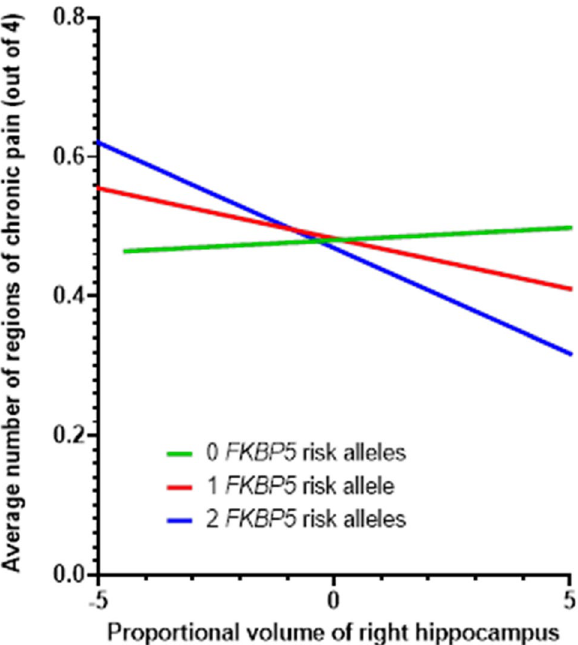
Figure 1. The number of FKBP5 rs3800373 risk alleles moderates the relationship between the right hippocampus and CMP severity. Shown is the relationship between right hippocampal brain volume and chronic multisite musculoskeletal pain (CMP) severity in individuals from the UKBB study cohort (n = 36,822). Right hippocampal brain volume was adjusted for head size and standardized (mean = 0, SD = 1), see “Methods”. Individuals with two copies of the FKBP5rs 3800373 risk allele (n = 3005) are represented by the blue line, individuals with one copy of the FKBP5rs3800373 risk allele (n = 15,327) are represented by the red line, and individuals with no risk alleles are represented by the green line (n = 18,490). As shown in Supplementary Table 4, relationships represented by the blue and red lines were statistically significant (p < 0.05).